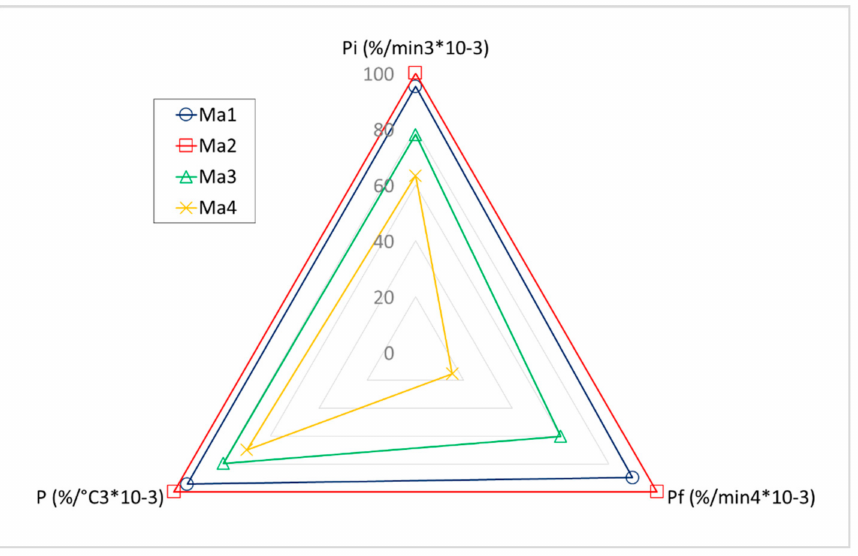
Figure 4. Pyrolysis